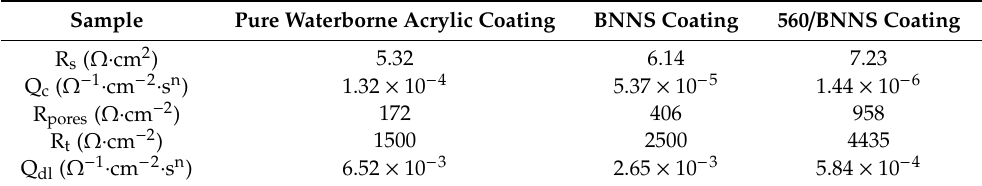
Table 2. EIS fitting parameters of various